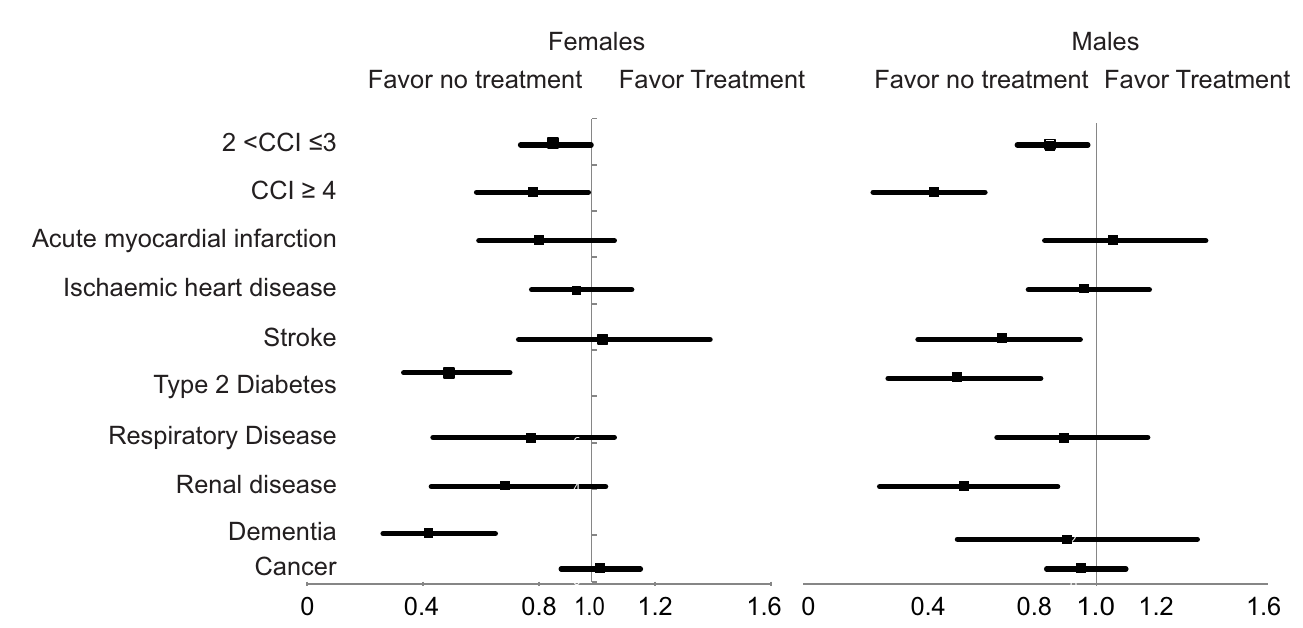
Fig 2. Association between chronic conditions and treatment initiation in the high-risk